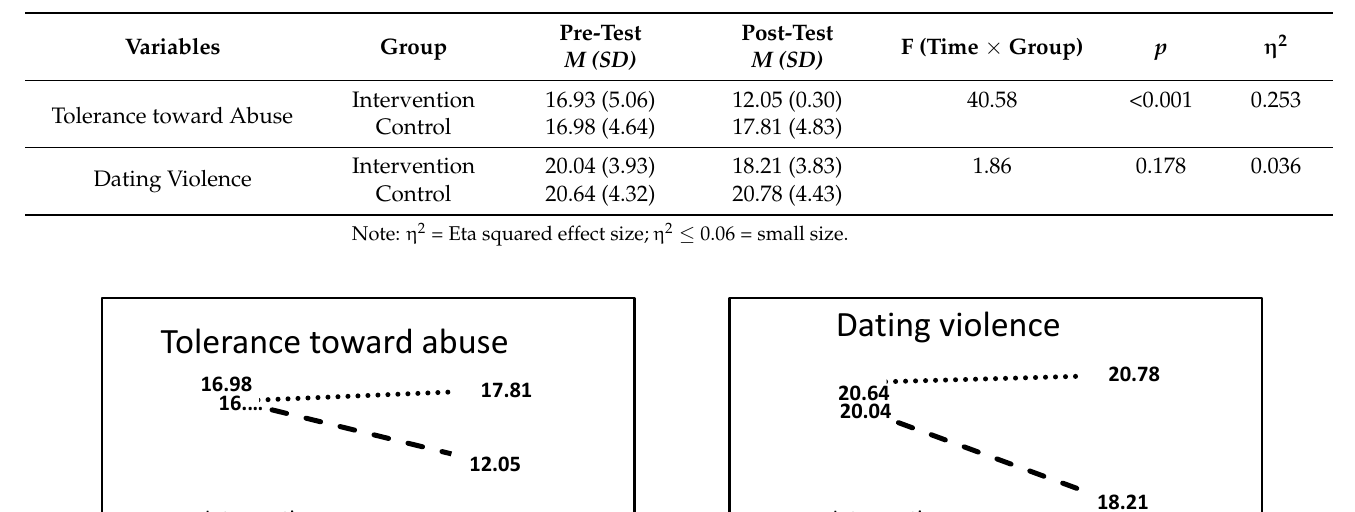
Table 2. Between-group effects and repeated measures analysis of variance (ANOVA 2 × 2) in tolerance toward abuse and dating violence.